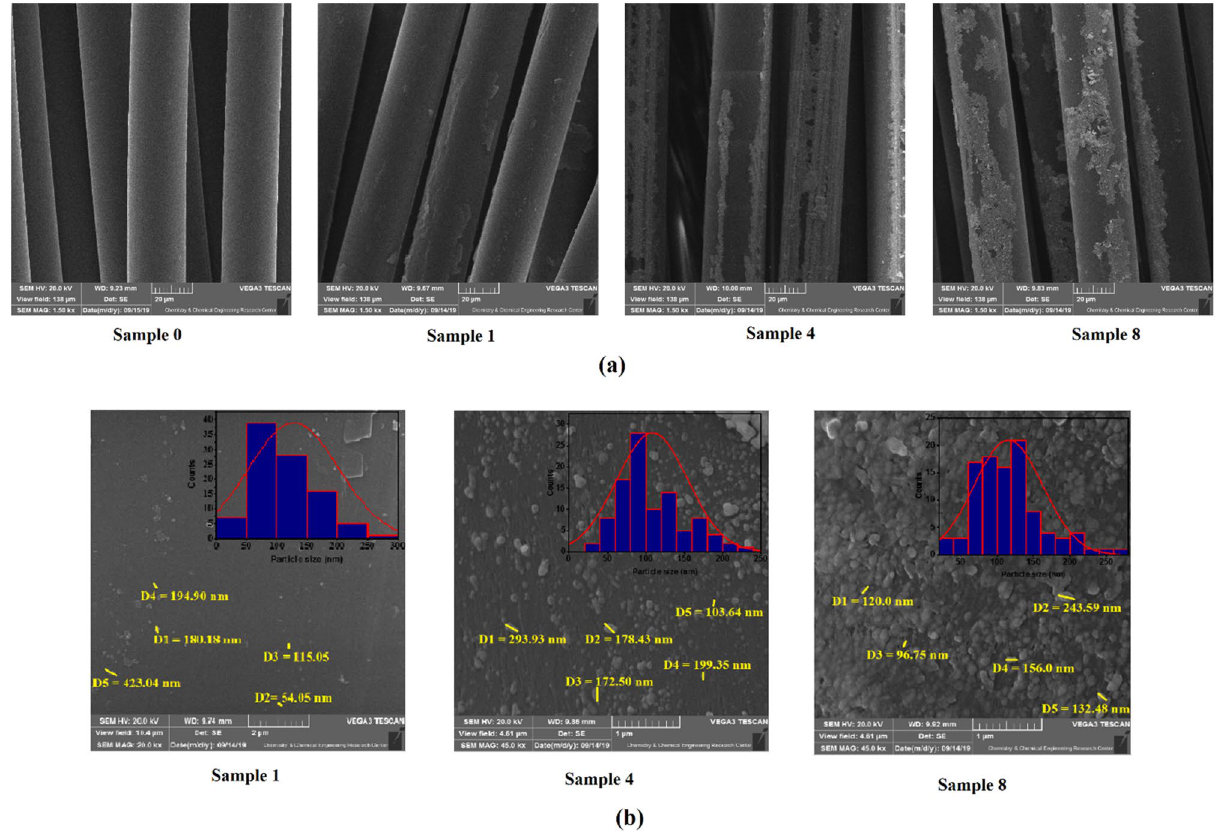
Figure 3. SEM images of coated and uncoated samples. ( a ) Deposition of SNPs on fabrics as a function of precursor concentration and sonication time, ( b ) Particle size and particle size distribution of deposited SNPs. Sample 0 (Uncoated fabric), Samples 1 and 4 (NS-coated fabrics at 2 and 50 mM silver nitrate concentrations, and 25 min sonication time, respectively), Sample 8 (NS-coated fabrics at 50 mM silver nitrate concentration and 50 min sonication